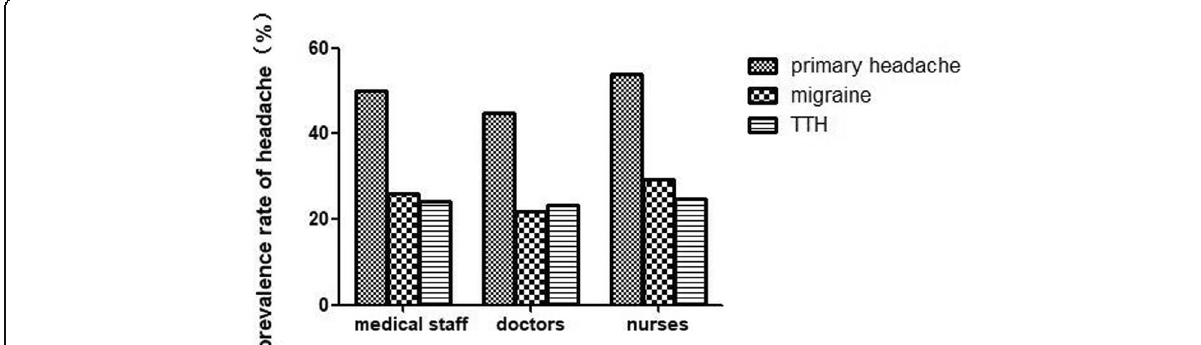
Fig. 1 Comparison of the prevalence of different types of headaches among medical staff, doctors and